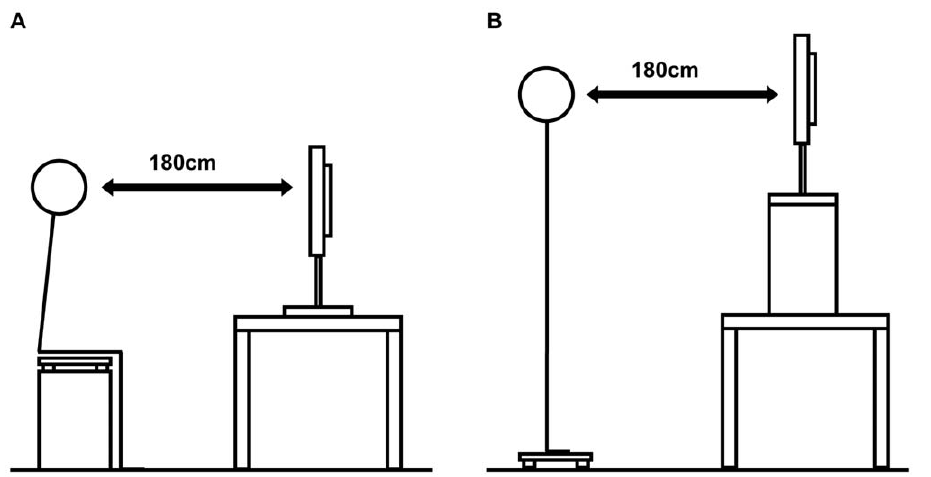
Figure 1. Experimental setup for the experiments. The sitting version is depicted in (A) and the standing version in (B).